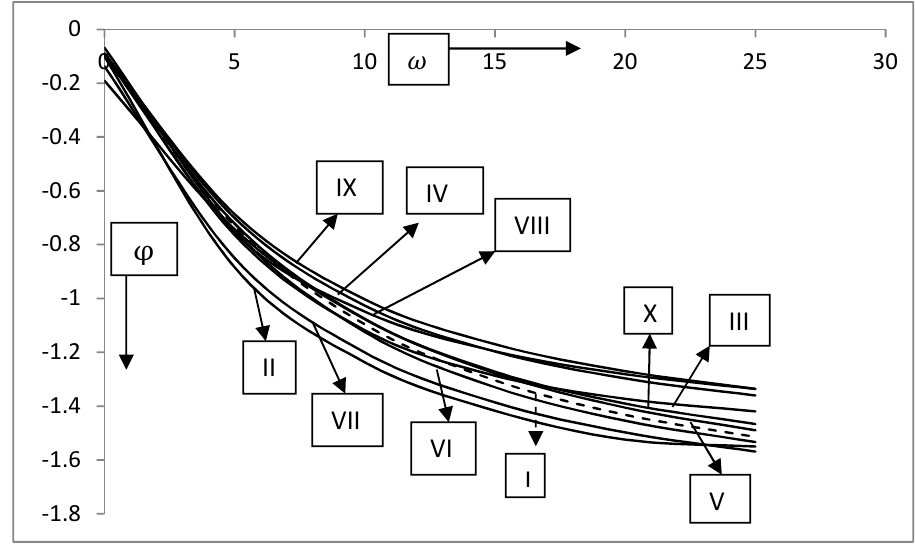
Fig. 3b. Phase of the skin